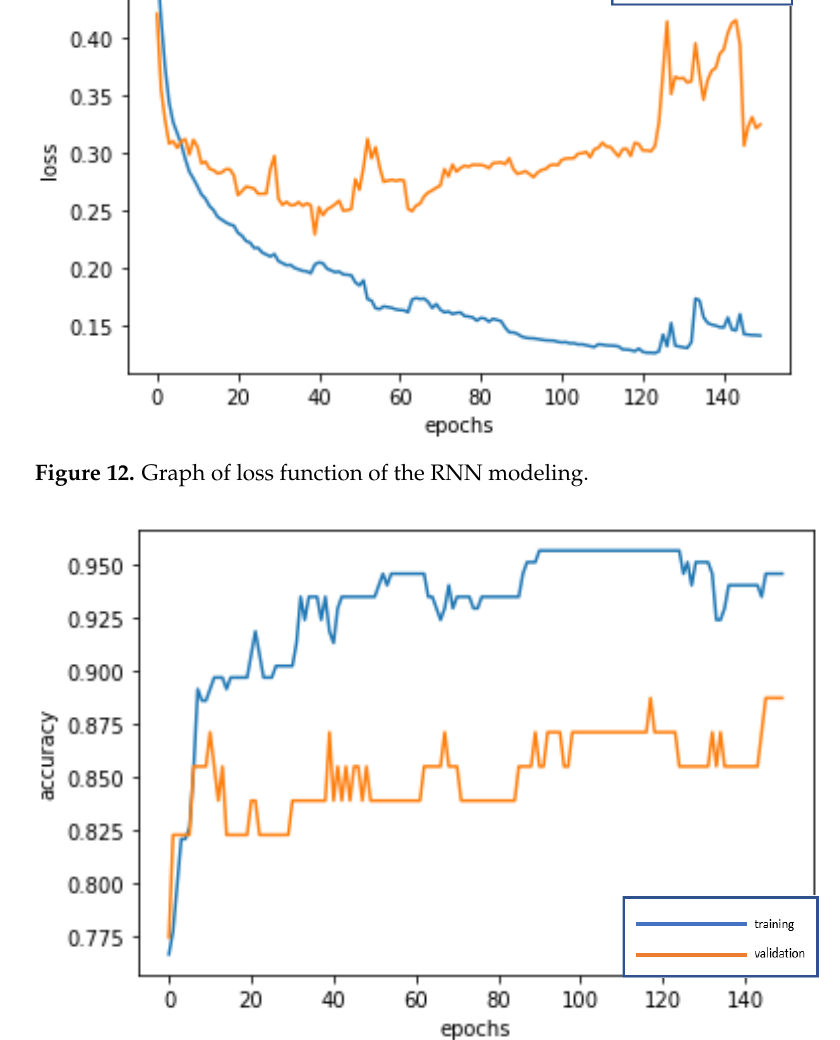
Figure 13. Accuracy line graph of the RNN modeling.